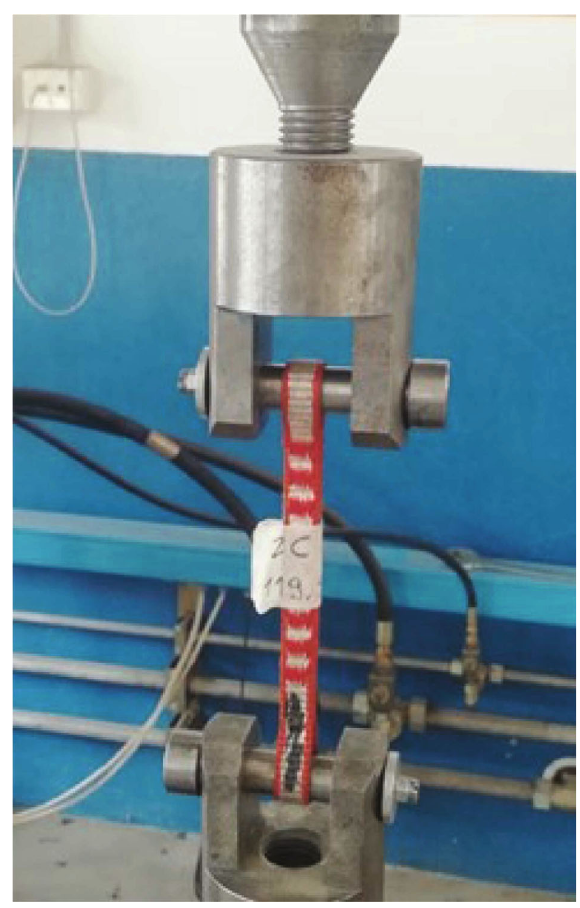
Figure 4: Polymeric specimen mounted on the grips and loaded in